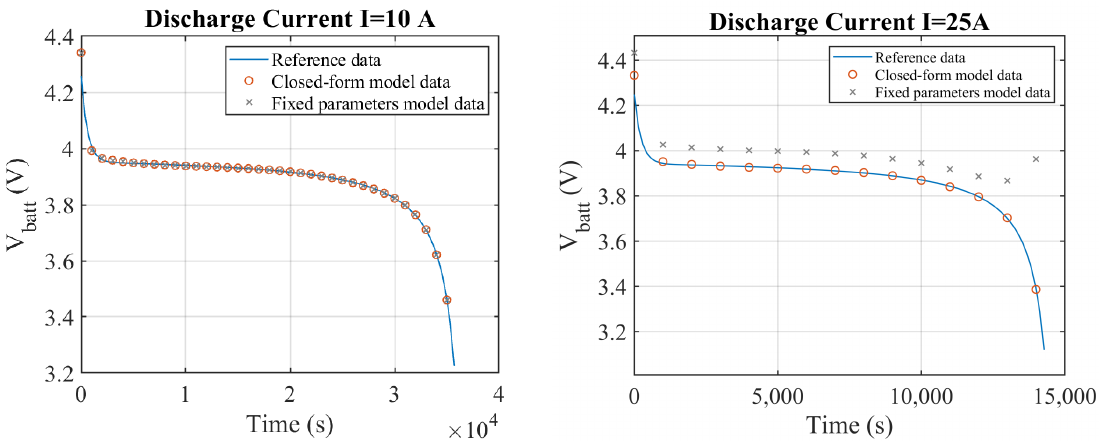
Figure 7. Discharge curves for two different current values: comparison between the results obtained through the proposed closed-form model and the fixed parameters